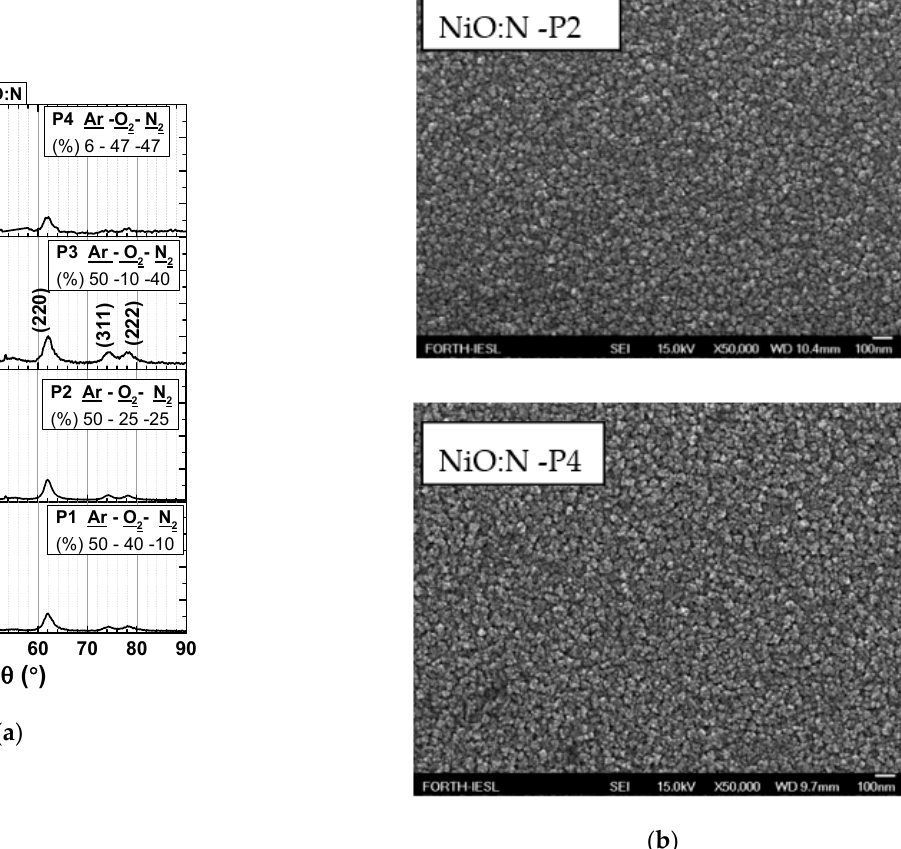
Figure 3. ( a ) XRD patterns of N-doped NiO films made in 50% Ar gas in plasma and varying %(O 2 -N 2 ) gases and ( b ) SEM images of N-doped NiO films in Ar-rich plasma (50% Ar, film P2) and Ar-deficient plasma (6% Ar, film P4). All films were deposited on Si substrates.